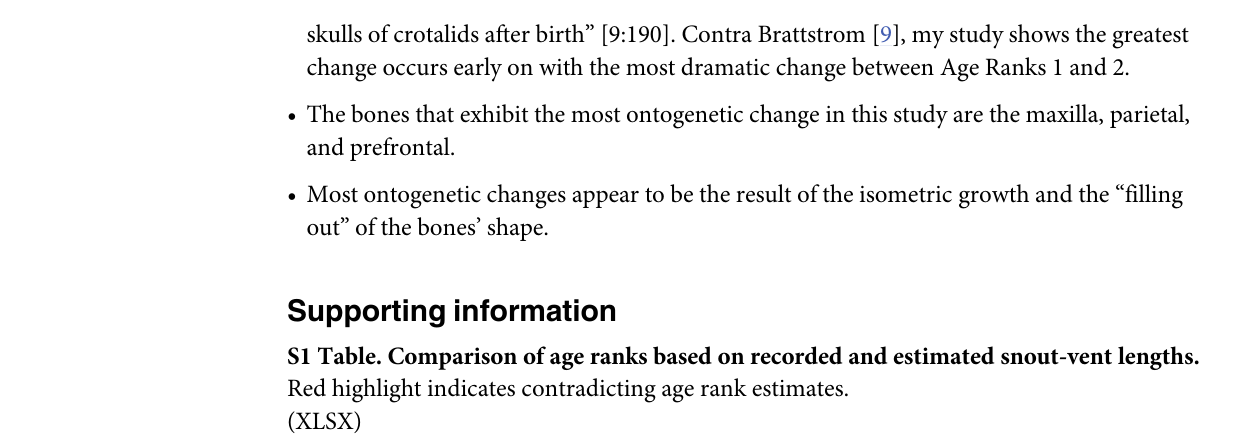
S1 Table. Comparison of age ranks based on recorded and estimated snout-vent lengths. Red highlight indicates contradicting age rank estimates.